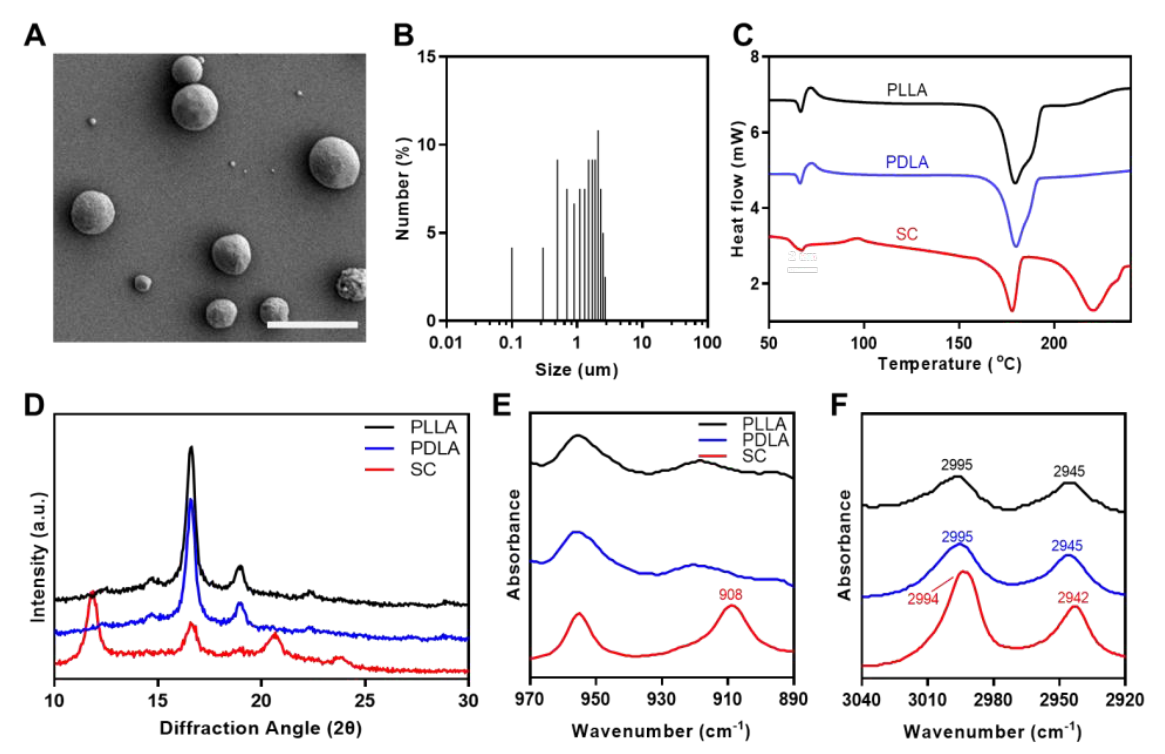
Figure 2. ( A ) SEM image and ( B ) size distribution of SC . Scale bar: 5 μm. ( C ) DSC thermograms, ( D ) XRD spectra, and ( E , F ) ATR − FTIR spectra of the PLLA, PDLA, and SC.